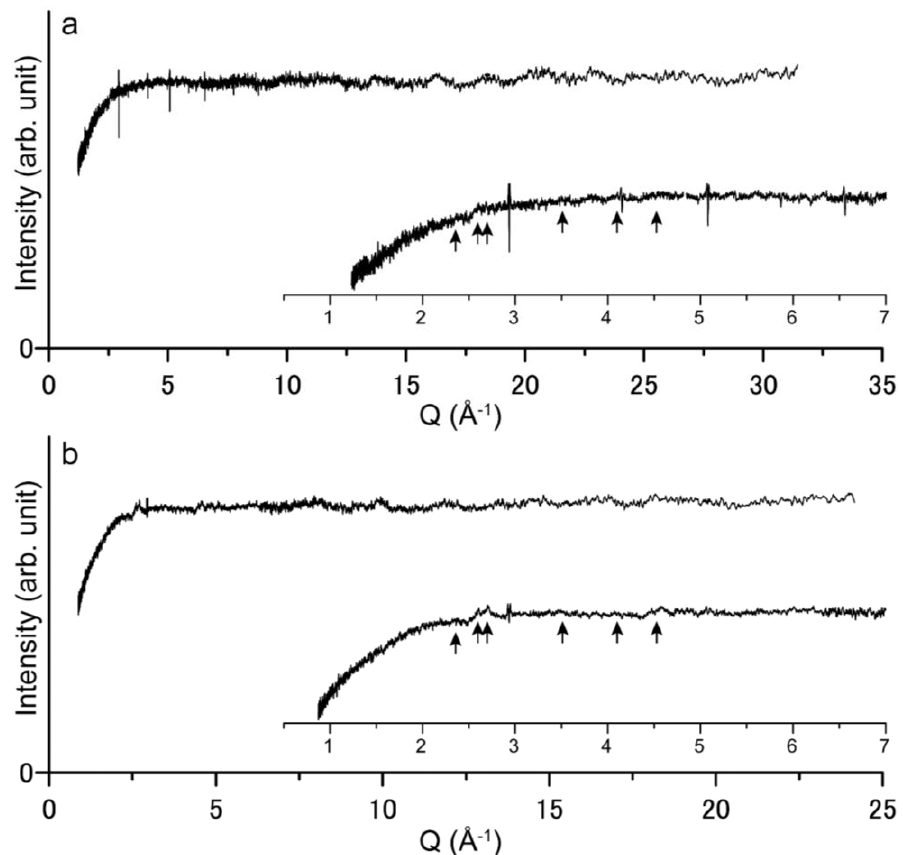
Figure 6. Neutron powder diffraction (NPD) patterns of the f-TiZr alloy: ( a ) NPD pattern from the high-resolution bank (Δ d / d ≈ 0.16%) and ( b ) that from the special environment bank (Δ d / d ≈ 0.5%). The intensities of both profiles initially increase with increasing Q , which is due to inelastic scattering. The inset profiles show the lowest Q regime which have the same vertical scale with the main figures. Arrows under both of the inset profiles indicate the positions of representative Bragg reflections that are observable when TiZr